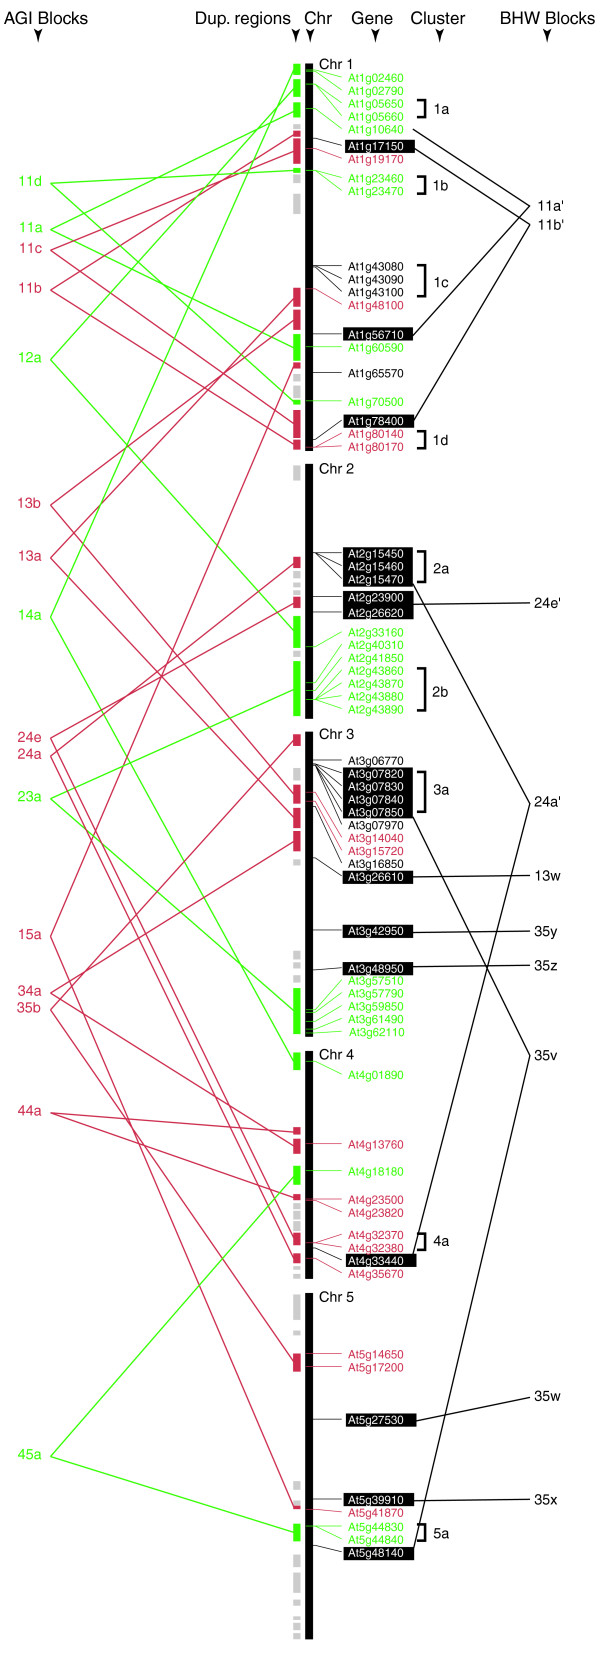
Mechanisms of Arabidopsis PG family expansion. The locations of Arabidopsis PGs are indicated on the Arabidopsis chromosomes. The tandem clusters are also indicated. They are color-coded based on the following scheme: PGs found in both duplicated regions of a block pair (green); PGs found in only one duplicated region of a block pair (red); and no PG is located in these blocks (gray). PGs covered by AGI blocks are either red or green, while PGs covered by BHW but not AGI blocks are with white text and black-boxed background. If PGs are found in both duplicated regions of a block, the gene names are linked. In addition, these gene names are italicized if they belong to the same clade. PGs that are not found in either AGI or BHW blocks are shown in black text. Tandem duplications are indicated by cluster designation. BHW block names were modified from the original designations of Blanc et al. [20]. BHW block names with a prime indicate that they overlap with AGI blocks of the same names. The reference for the block names can be found in Additional data file 2.